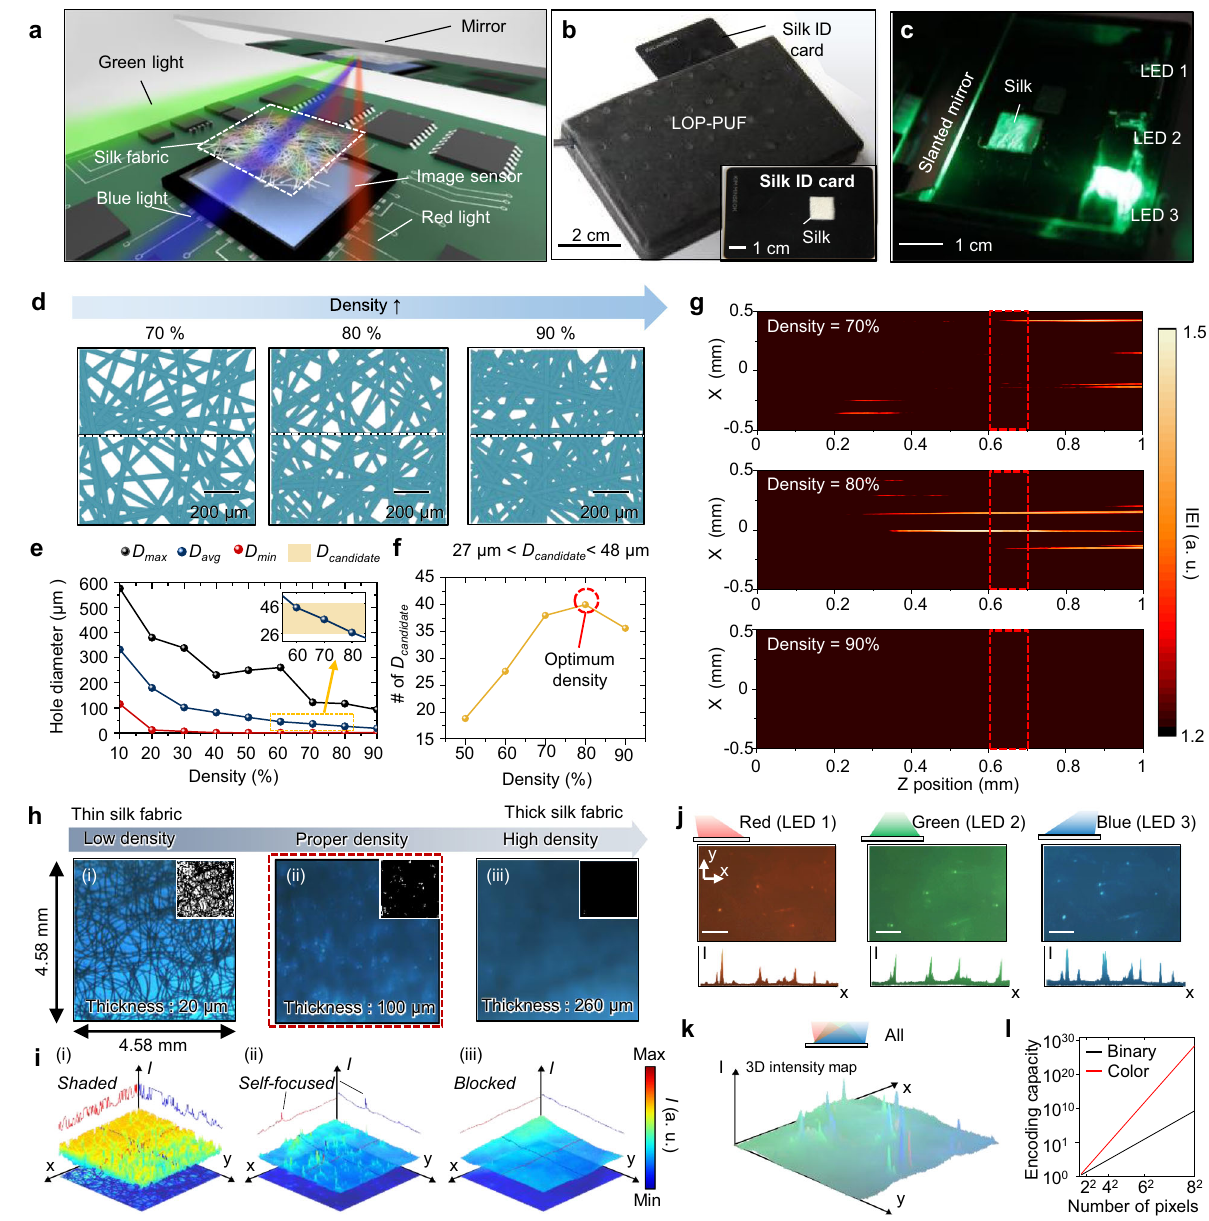
Fig. 3 Lens-less, optical, and portable physical unclonable function (LOP-PUF). a Schematic illustration of the proposed LOP-PUF module. b Optical image of the sealed LOP-PUF. The inset shows a silk identi fi cation (ID) card. c Photograph of the proposed LOP-PUF module in the working status. d Three virtual fi ber media with density levels of 70, 80, and 90%. The dashed lines represent the one-dimensional simulation domain for ( g ). e , f Opening diameter and D candidate value as a function of density. g Electric fi eld pro fi les of the three virtual fi ber density levels of 70, 80, and 90%. The digitized |E| signi fi es the captured photo-signal by the image sensor. h Obtained raw data from the LOP-PUF using silk with different density levels. In the red dashed box, the self-focused spots are shown. Other areas display the absence of focal spots. The inset images are binarized raw data. i Three-dimensional normalized intensity for three density levels of silk cocoons. j Lens-less images (top) and cross-sectional intensity pro fi les (bottom) under illumination by three separate, colored LEDs from three different angles ( − 15, 0, and + 15°). The scale bars are 300 μ m. k Three-dimensional intensity map for illumination under all light sources. l Encoding capacity of the LOP-PUF using tri-colors (red) and mono-color